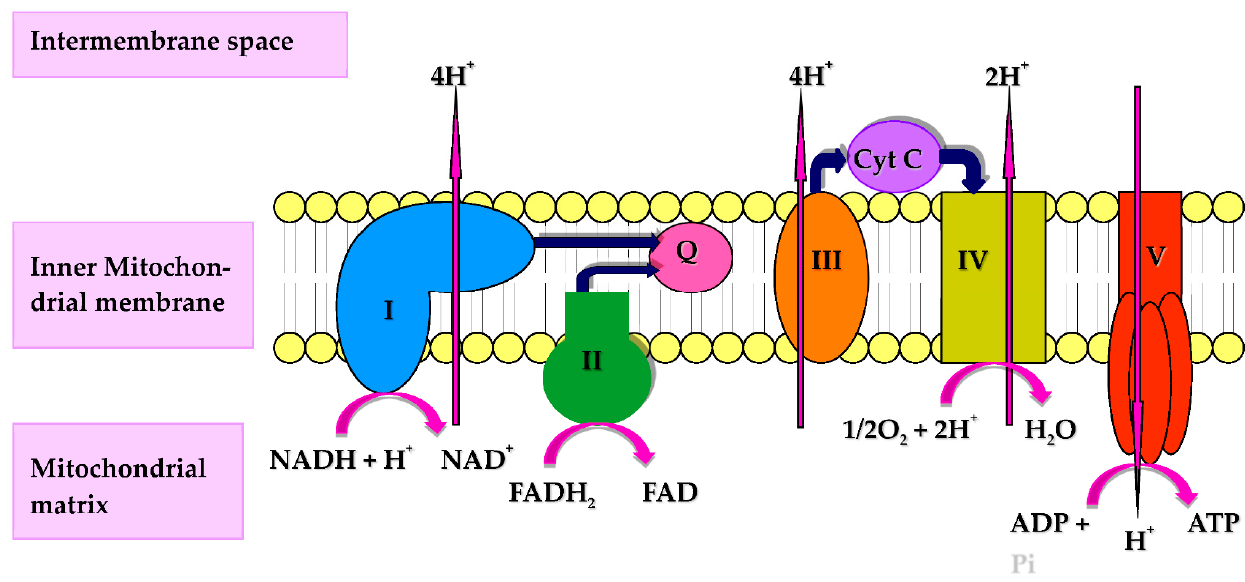
Figure 1. Diagram of the mitochondrial respiratory chain (MRC) and complex V illustrating proton (H + ) movement during oxidative phosphorylation. Q: Coenzyme Q 10 ; Cyt C: Cytochrome c.